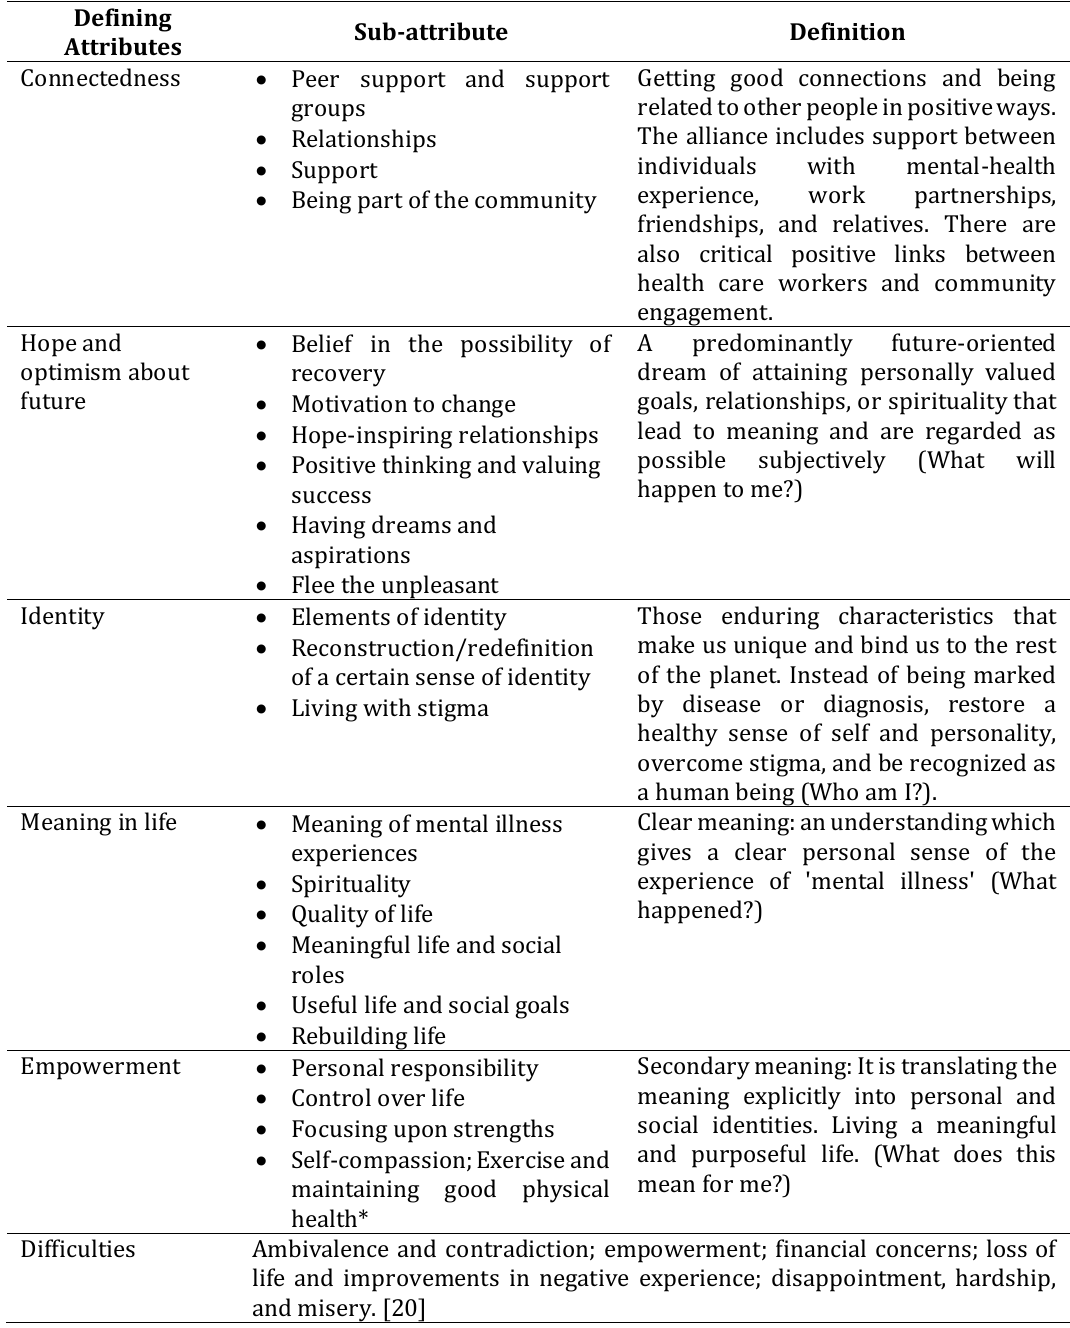
Defining Attributes of Personal Recovery of